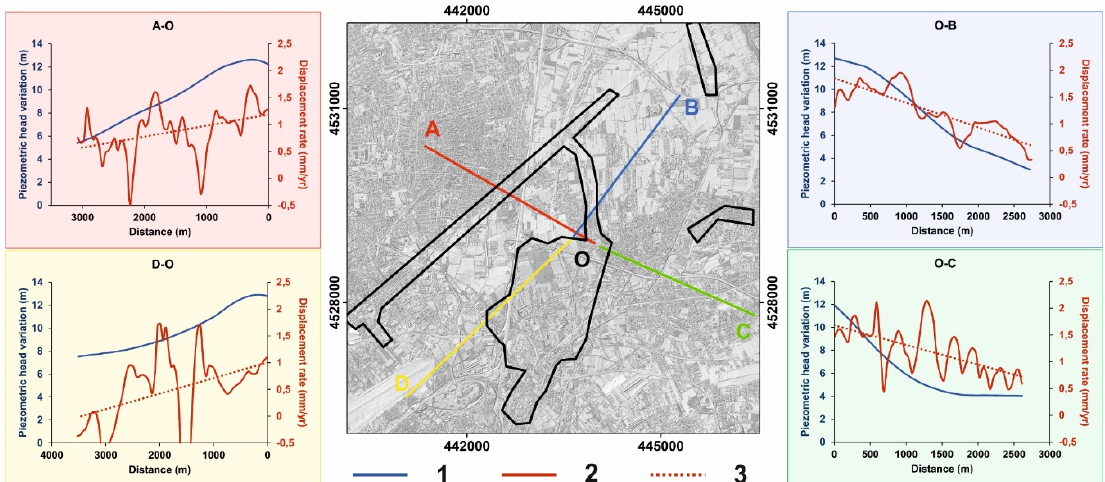
Figure 9. Scheme of the radius of influence of Lufrano wells field during the recovery period. In the middle, study area with profile traces. On both sides, ERS displacement rates (period 1992–2000, see Figure 5a) vs. piezometric head variation (period 1989–2002, see Figure 6a) along the section traces. Legend: 1) piezometric head variation profile; 2) displacement rate profile; 3) trend of displacement rate profile.